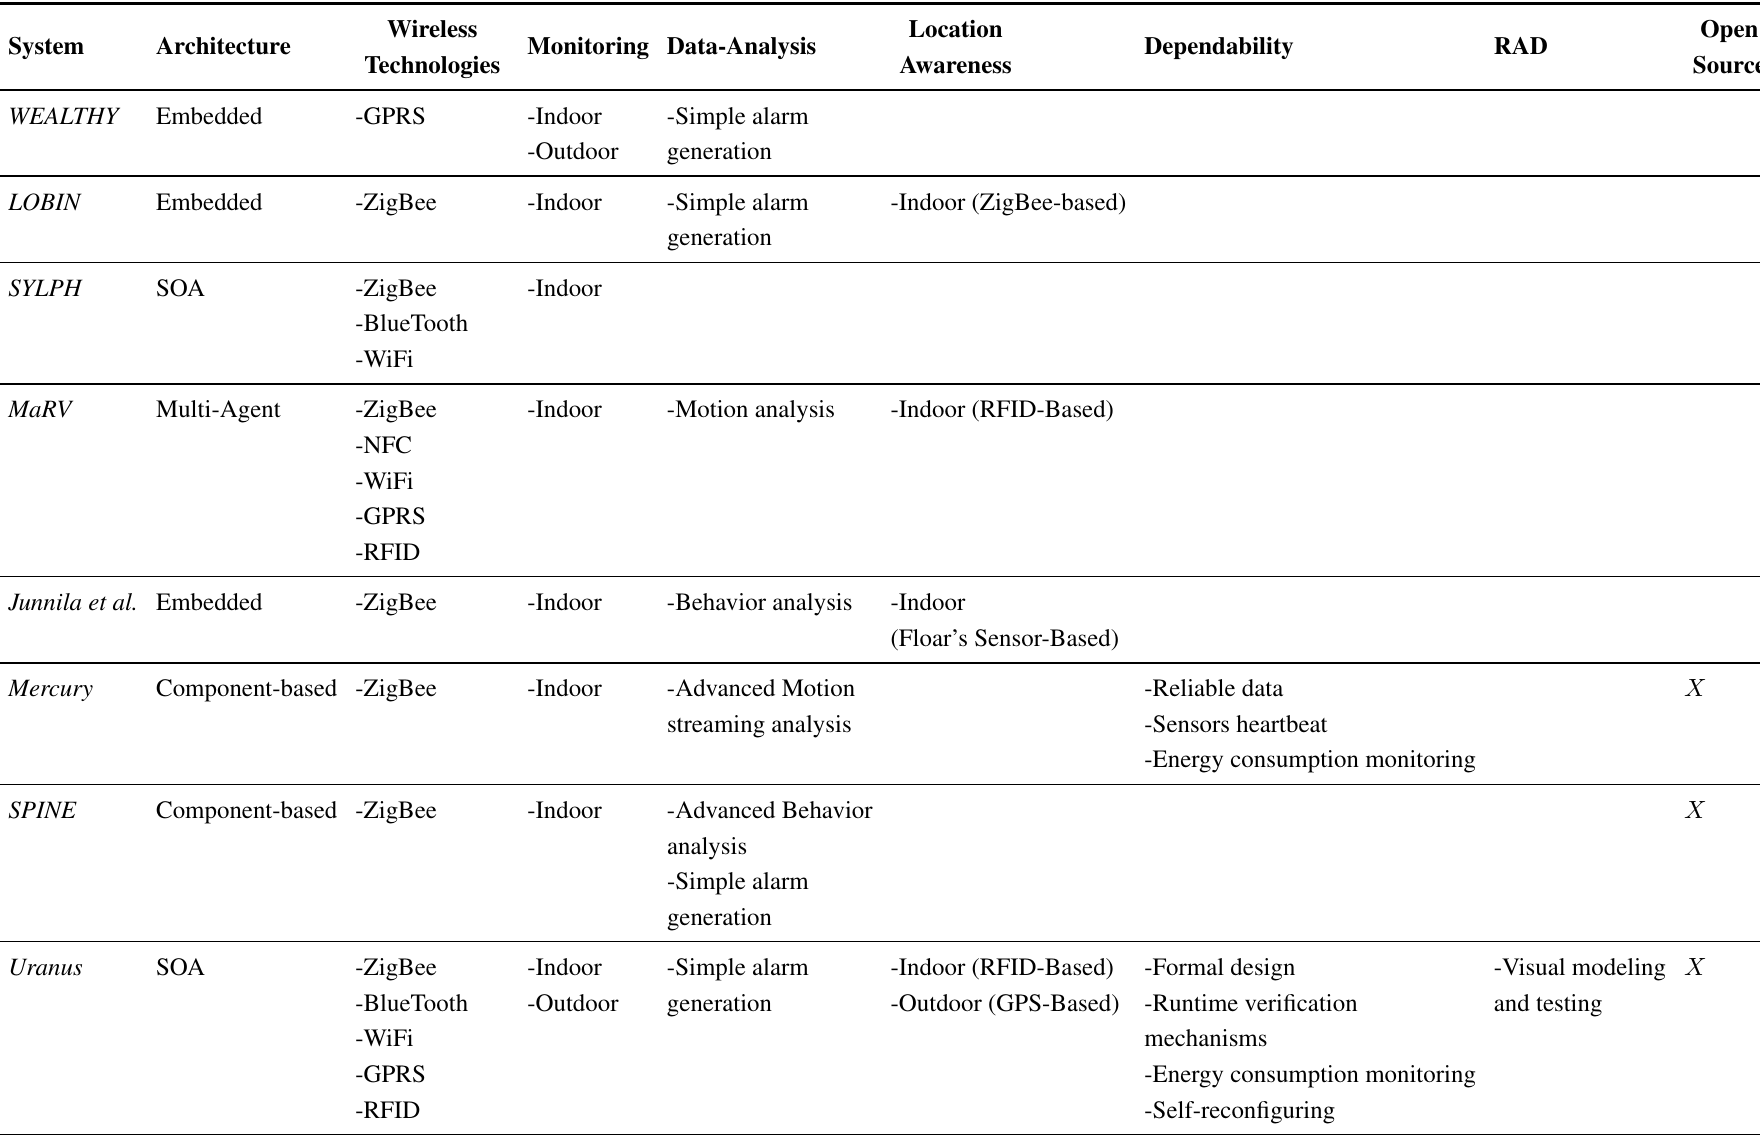
Table 2. The Main Characteristics of Systems and